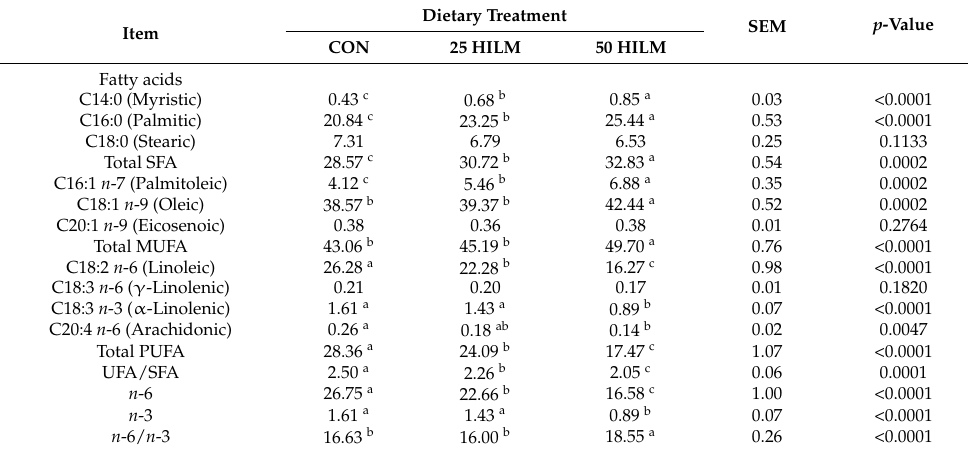
Table 5. Effect of dietary Hermetia illucens larvae meal (HILM) inclusion level on the fatty acid profile in abdominal fat of broiler chickens.